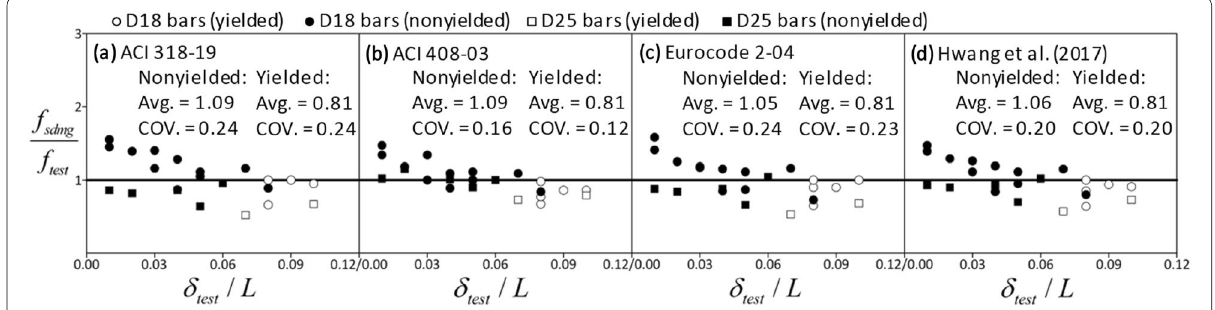
Fig. 13 Comparison of tested bar stress with predictions considering impact energy